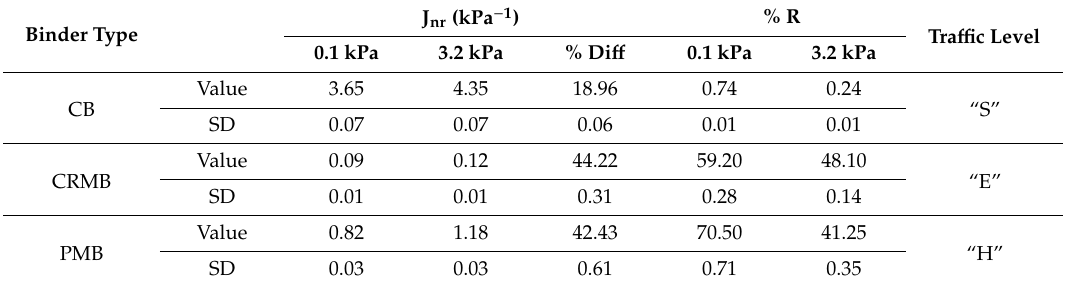
Table 6. Results of the Multiple Stress Creep Recovery (MSCR) test.